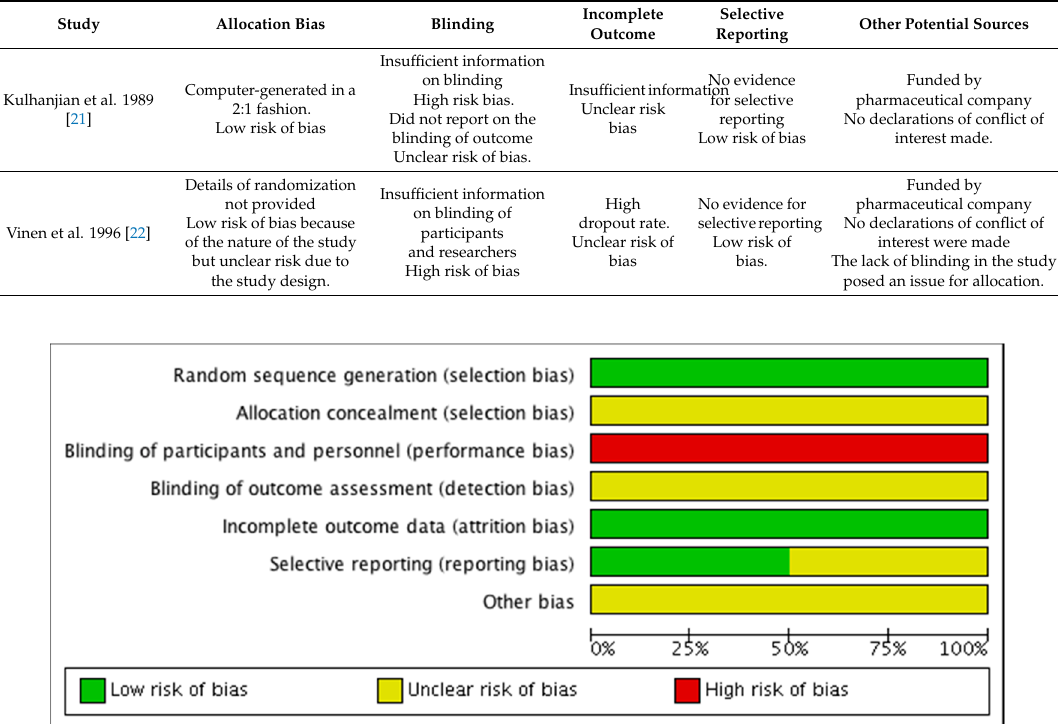
Table 2. Risk of bias in the included studies (randomised controlled trials (RCTs)).